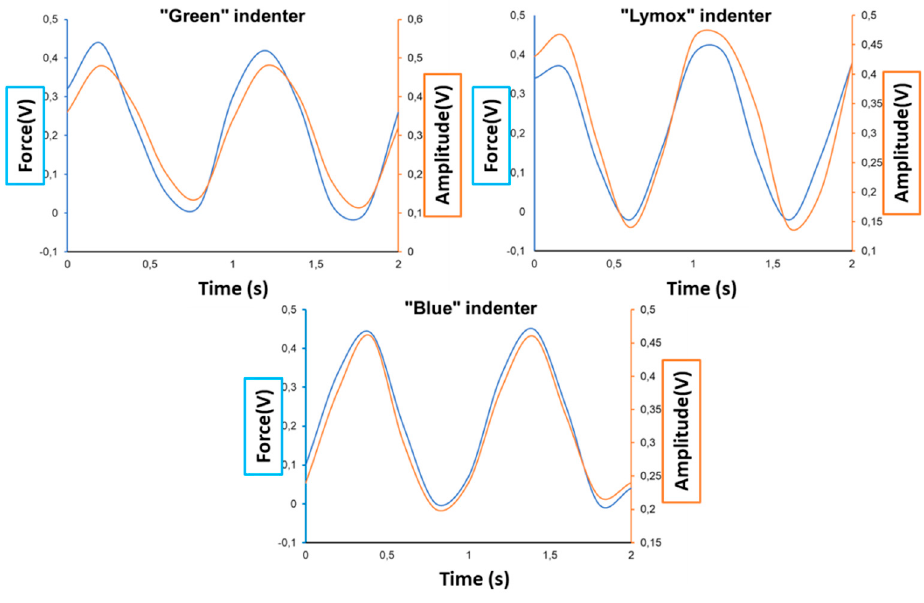
Figure 4. Evolution of raw applied signal force and raw response signal amplitude (both processed with fast Fourier transformation (FFT)) for various tungsten cone indenters.